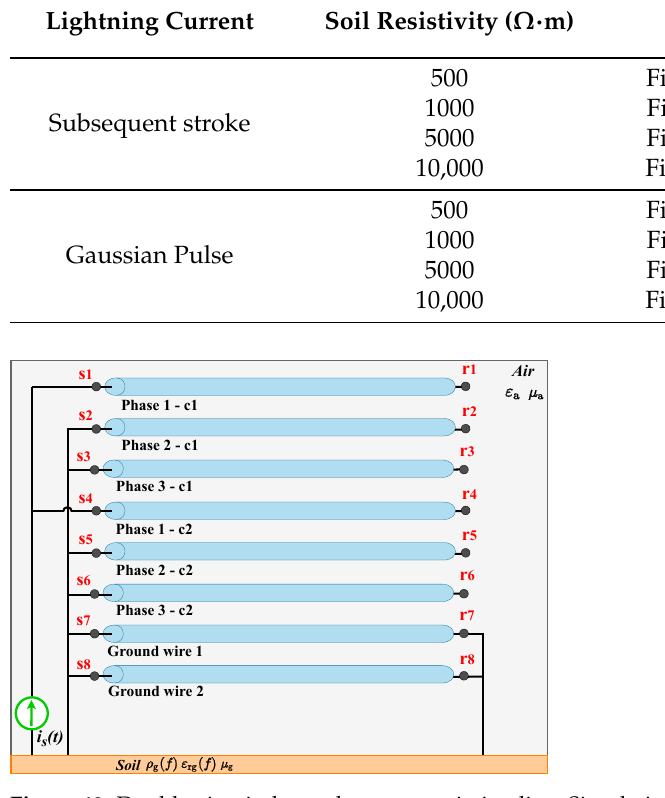
Figure 12. Double-circuit three-phase transmission line: Simulation